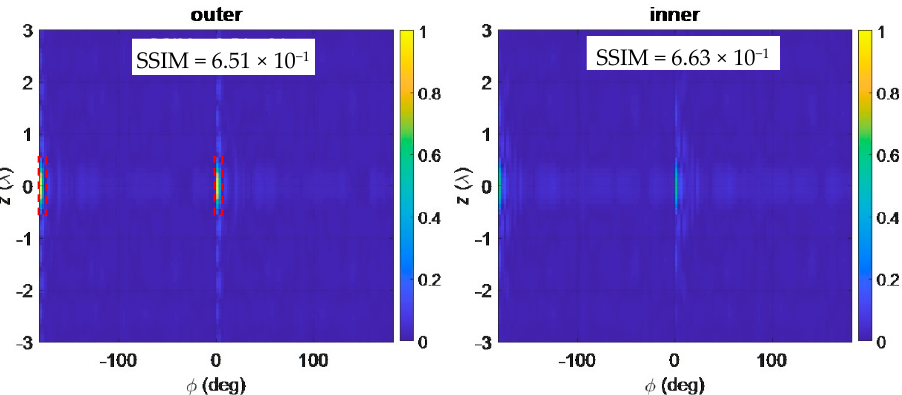
Figure 12. Reconstructed 2D images with MGs placed on the outer pipe. The red, dashed lines show the locations of the MGs.